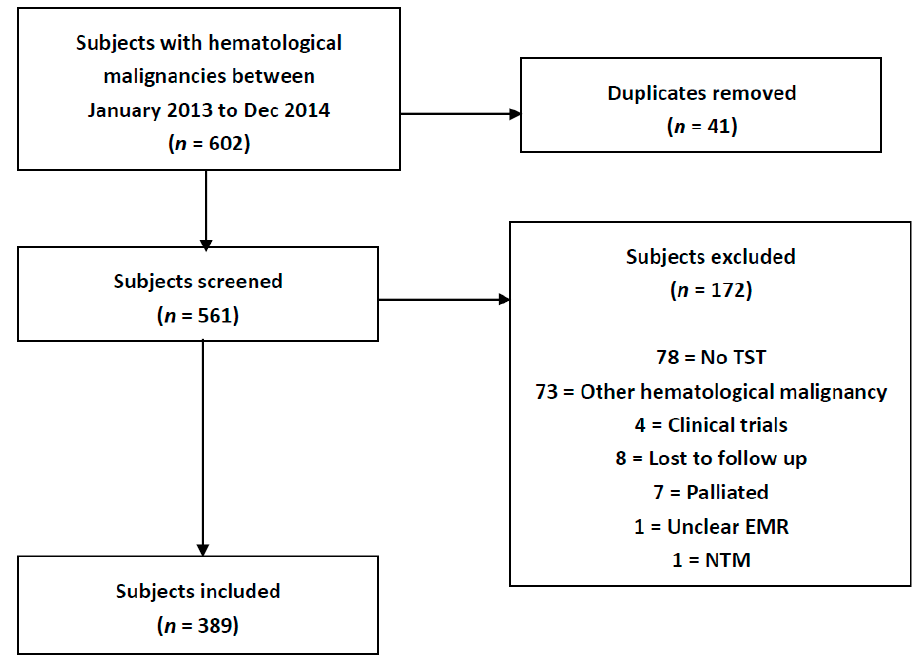
Figure 1. Study Flow Diagram.